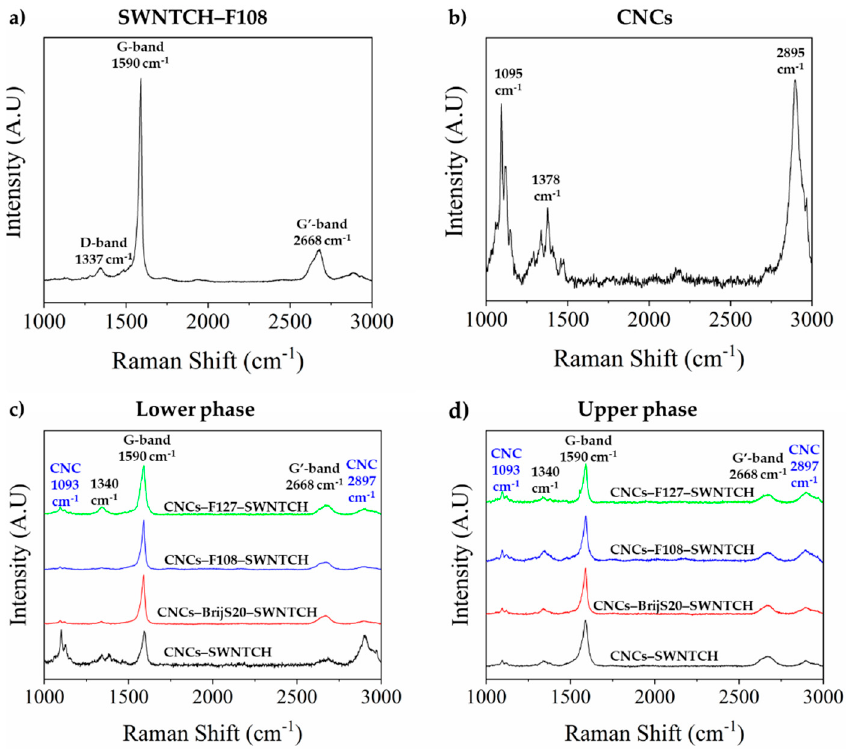
Figure 3. Raman scattering of ( a ) F108–SWNTCH dried dispersion, ( b ) CNC powder, and ( c ) lower and ( d ) upper phases of dried films prepared from dispersions of: CNC–SWNTCH ( — ), CNC–BrijS20–SWNTCH ( — ), CNC–F108–SWNTCH ( — ) and CNC–F127–SWNTCH ( — ).